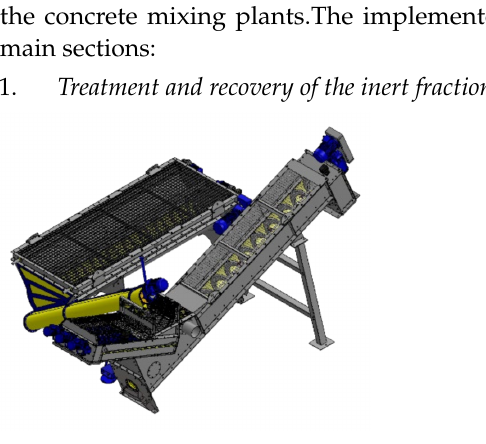
Figure 1. Treatment technology for inert fraction recovery. Mechanical system consisting of buffer and screws for the separation of fine aggregates (d < 5 mm) and coarse aggregates (d > 5 mm).